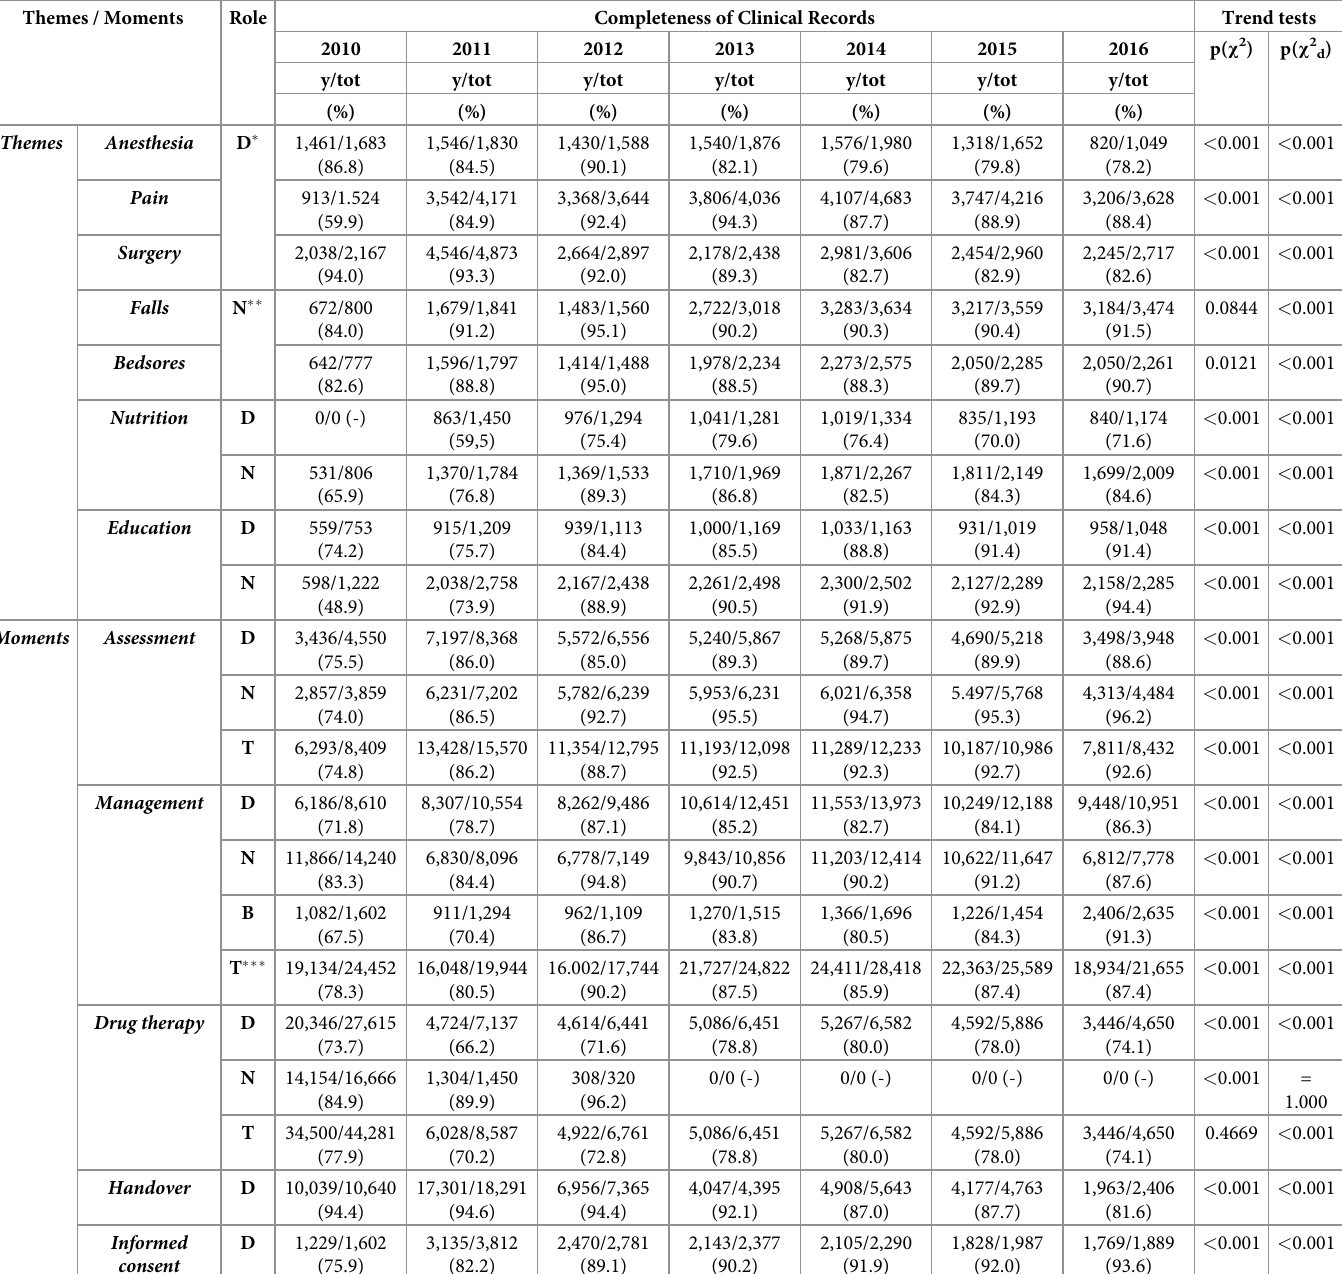
Table 2. Trend tests by themes and by moments and professional